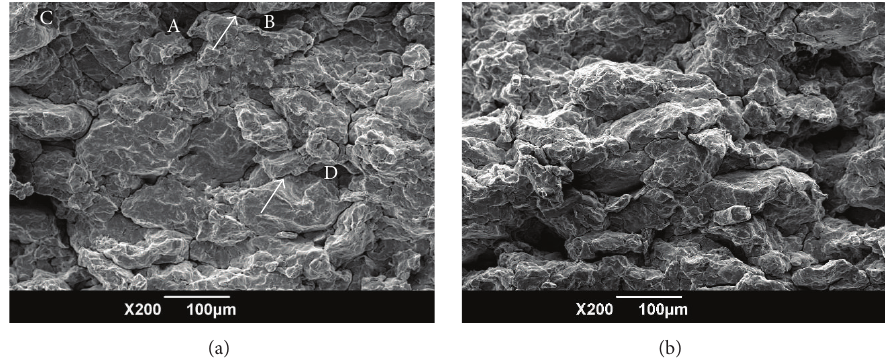
Figure 9: Fracture surfaces of SMCs at different annealing methods: (a) 200 ∘ C for 2 h and (b) 130 ∘ C for 1h + 200 ∘ C for 1h.